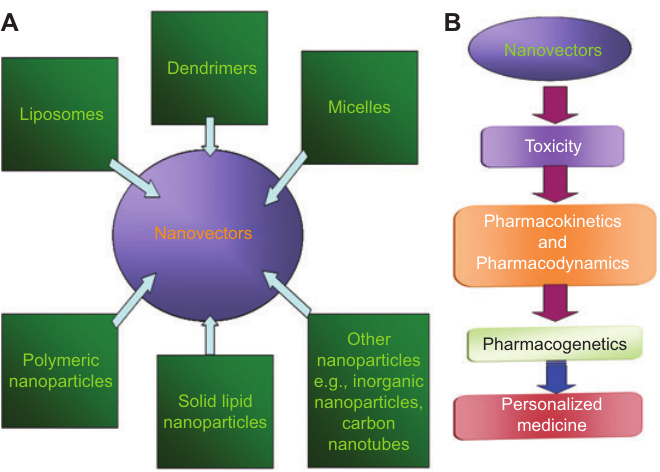
Figure 1 (A) Nanoparticles as nanovectors: nanovectors are the principal constituents of nanopharmaceuticals, which have immense appli- cations in the fi eld of personalized medicine. The fi gure essentially depicts the divergent classes of nanoparticles with unique photophysical attributes being prospected as nanovectors. (B) Nanovectors in personalized medicine: the failure of current therapeutic regimens in providing solutions to problems affecting the management of highly debilitating and mortality causing diseases such as cancer has lead to the establish- ment of a novel therapeutic regimen of personalized medicine. A key to prospecting the putative nanopharmaceuticals in personalized